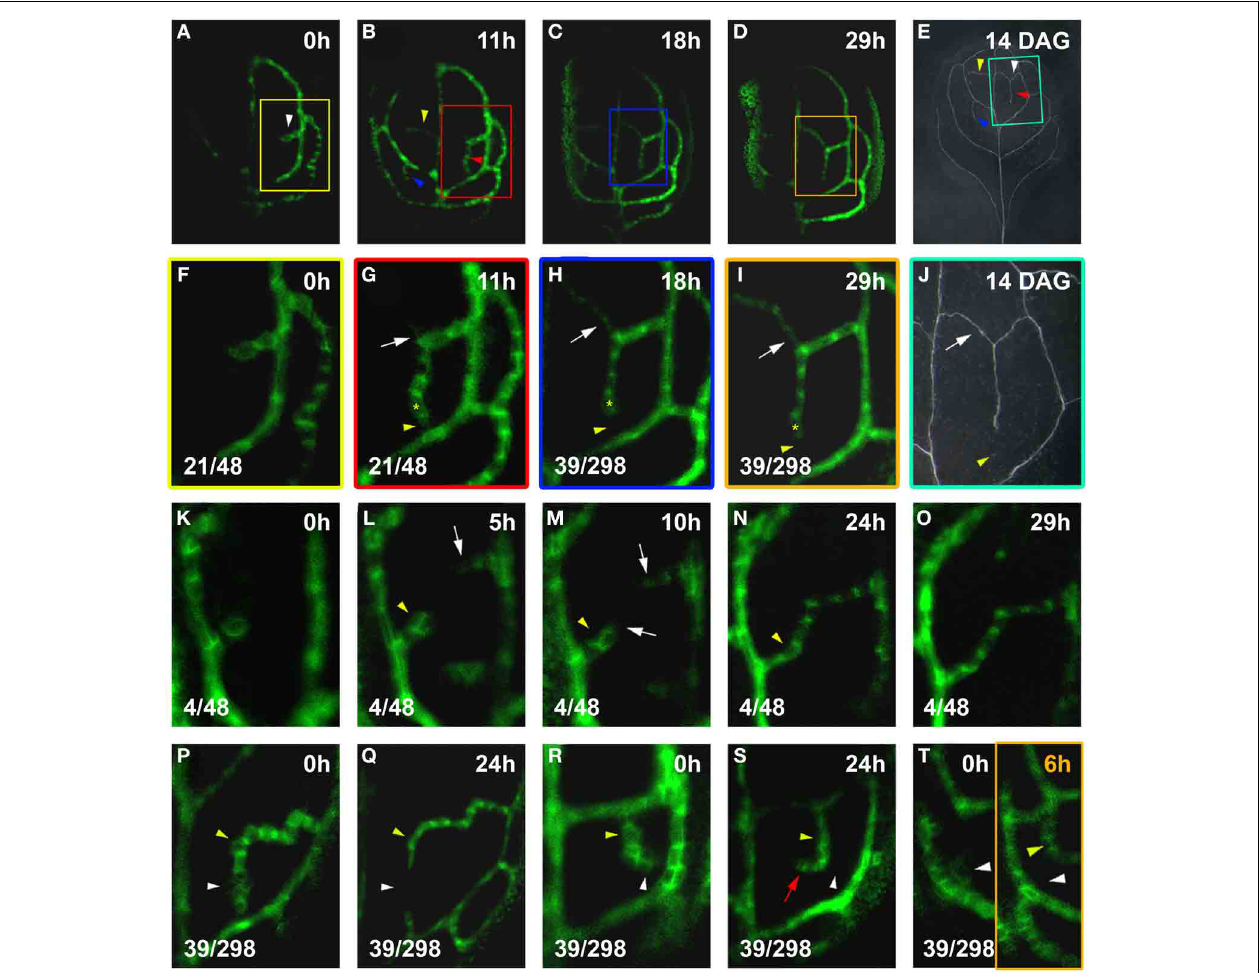
FIGURE 6 | hPED fusion and instability. Top right time after first visalization ( t = 0; A–D , F–I , K–T ) or leaf age in DAG (E,J) . Bottom left, reproducibility quotient ( Table 2 ). Scale bars: (A–D) 20 µ m; (E) 1mm; (F–I , K–T) 10 µ m; (J) 0.5mm. (A–E) PIN1:GFP expression and final vein pattern of the same leaf. Note the presence of one hPED at 0h, and three new hPEDs at 11h (arrowheads in A,B ). Corresponding veins marked by arrowheads in (E) . (F–J) Enlargements of boxed areas in (A–E) , respectively. A freely-ending hPED (F) , has extended and fused with the first loop below (yellow arrowhead, G ). Emerging side branch (white arrow in G ), turned into a second connected hPED (white arrow in H,I ). Lost PIN1 expression (yellow arrowhead in H,I ) resulting in the formation of one connected vein (white arrow in J ) with a freely-ending, side branching vein (yellow arrowhead in J ) in final vein pattern. Yellow asterisk marks same cell in G–I , as positional reference. (K–O) Freely-ending hPED branching from the first loop (K) , followed by second freely-ending hPED from the midvein (white arrow in L ). White arrows in